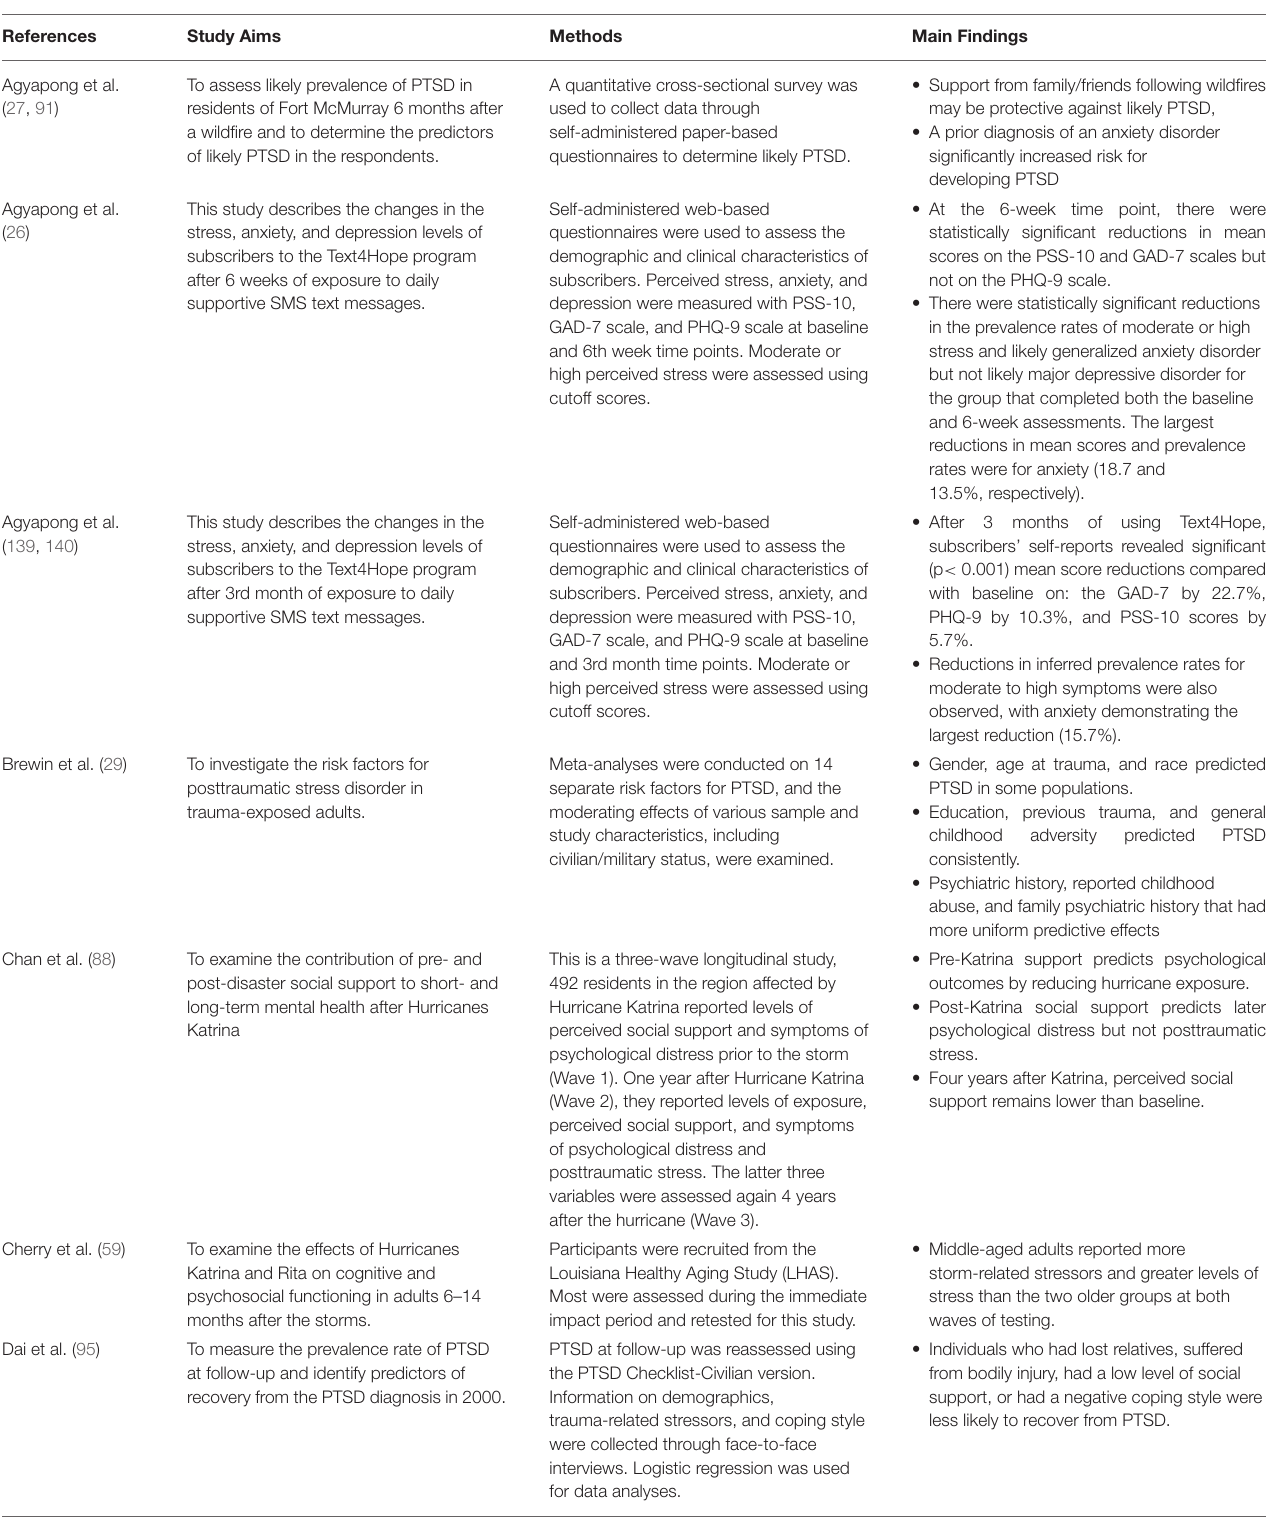
TABLE 1 | Summary of studies on key social determinants and protective factors for mental health following